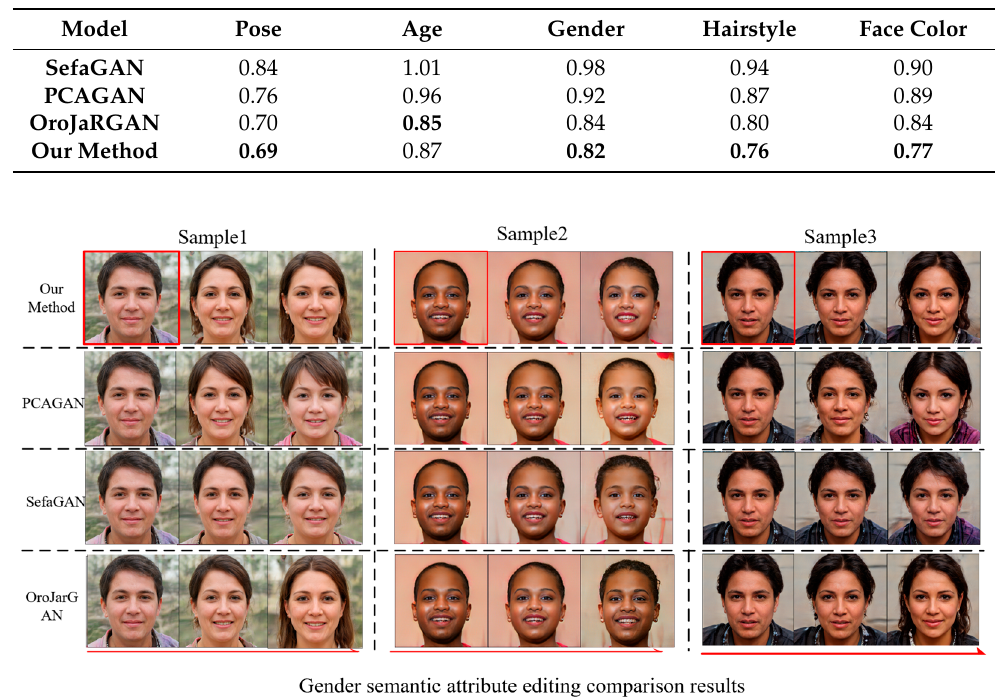
Table 2. PPL Scores of FFHQ dataset semantic attribute directions ( ↓ ).